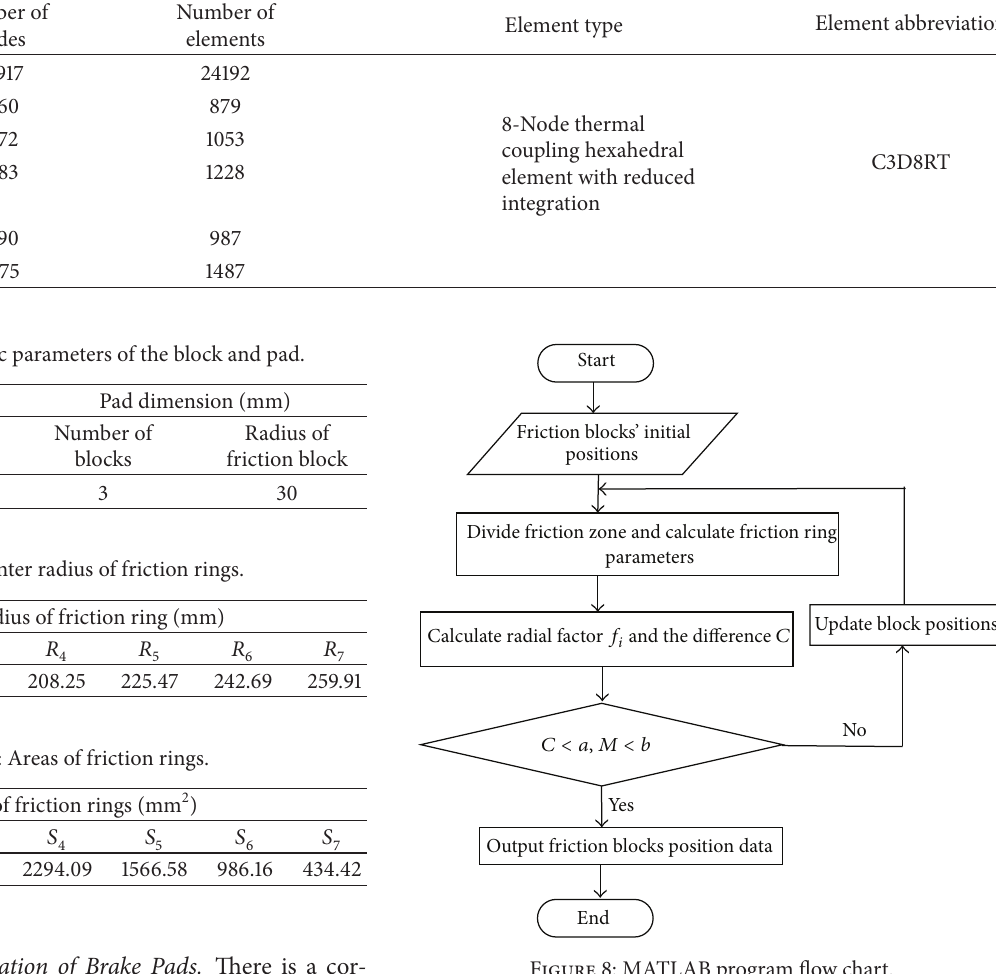
Table 8 is the A1 data of optimized brake pad structure of 5 friction blocks, in which 𝑟 is the friction ring radius of friction block center on the brake disc and 𝜃 is the circumferential angle (Figure 9) of friction block center on the brake disc. Refer to Figure 10 for the optimized brake pad structure obtained on basis of the above data and nonoptimized brake pad structure